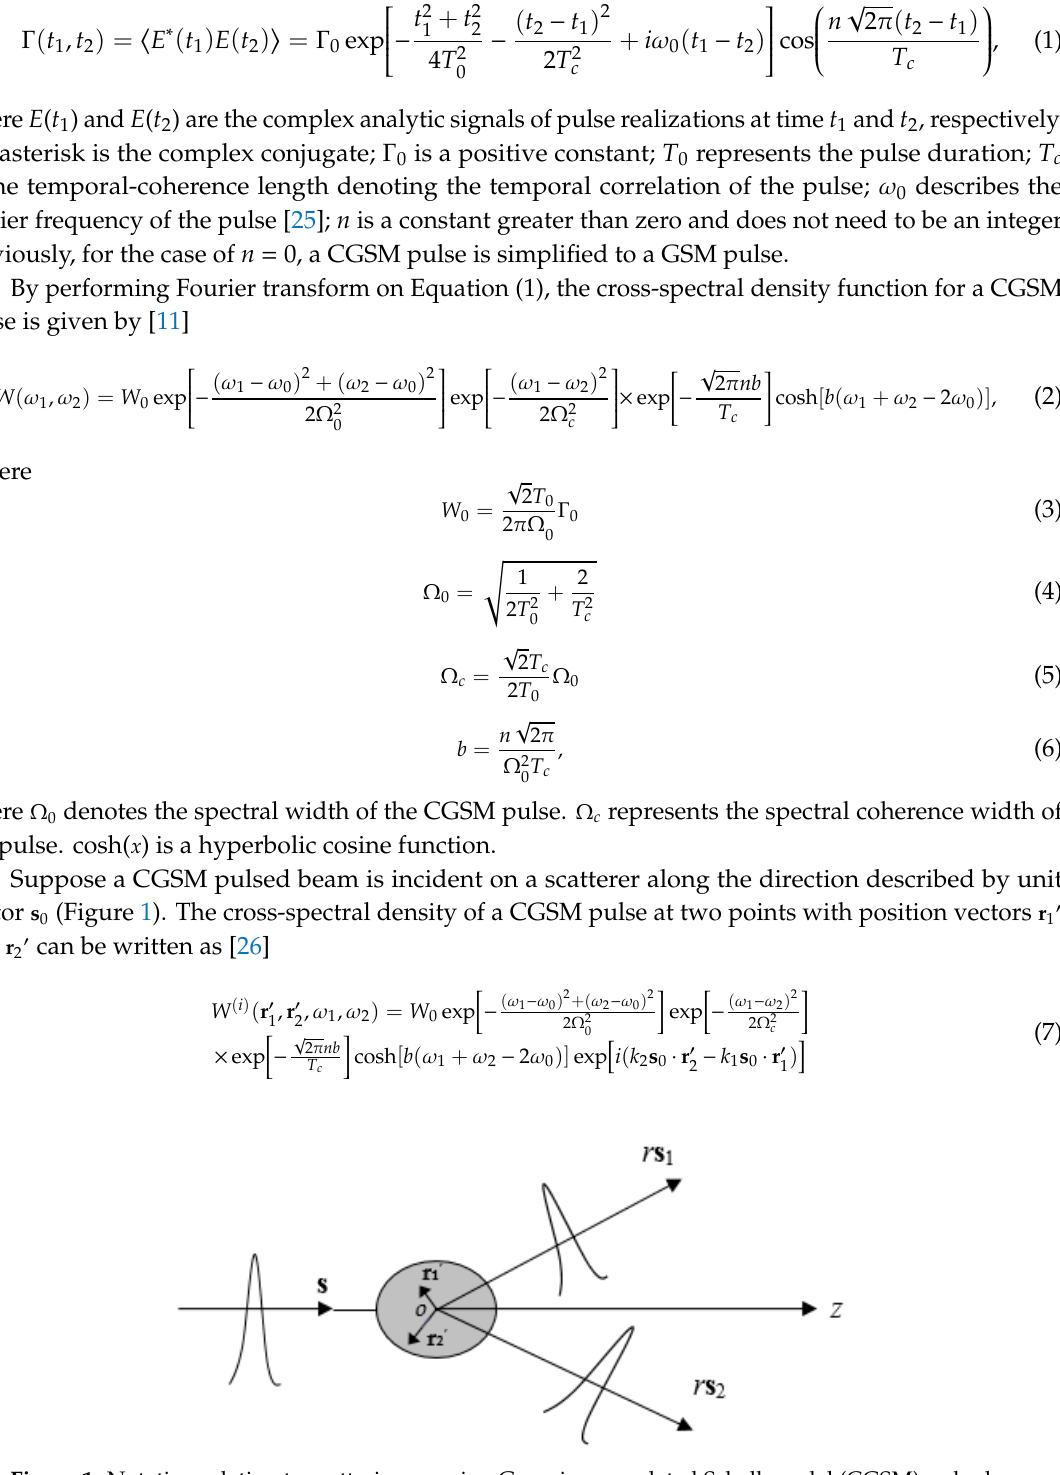
Figure 1. Notation relating to scattering a cosine-Gaussian-correlated Schell-model (CGSM) pulse by a